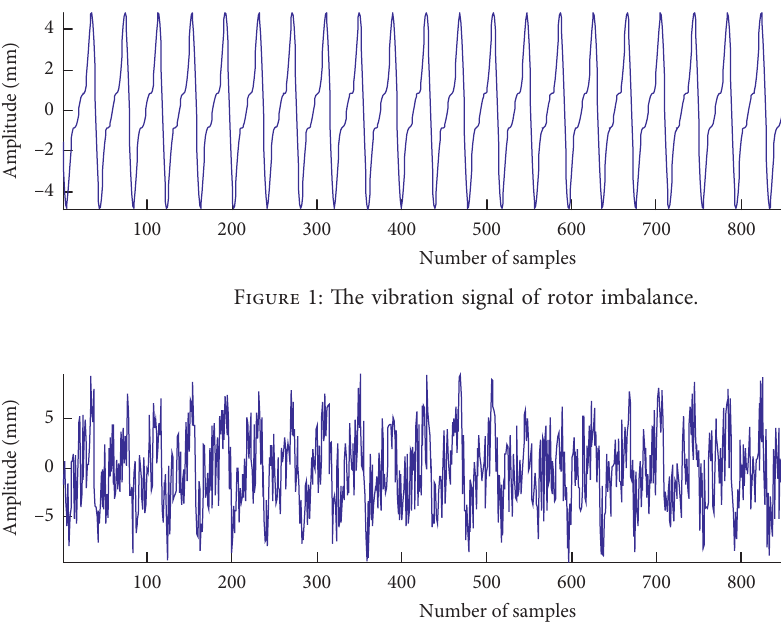
Figure 2: The complex signal with heavy noise.